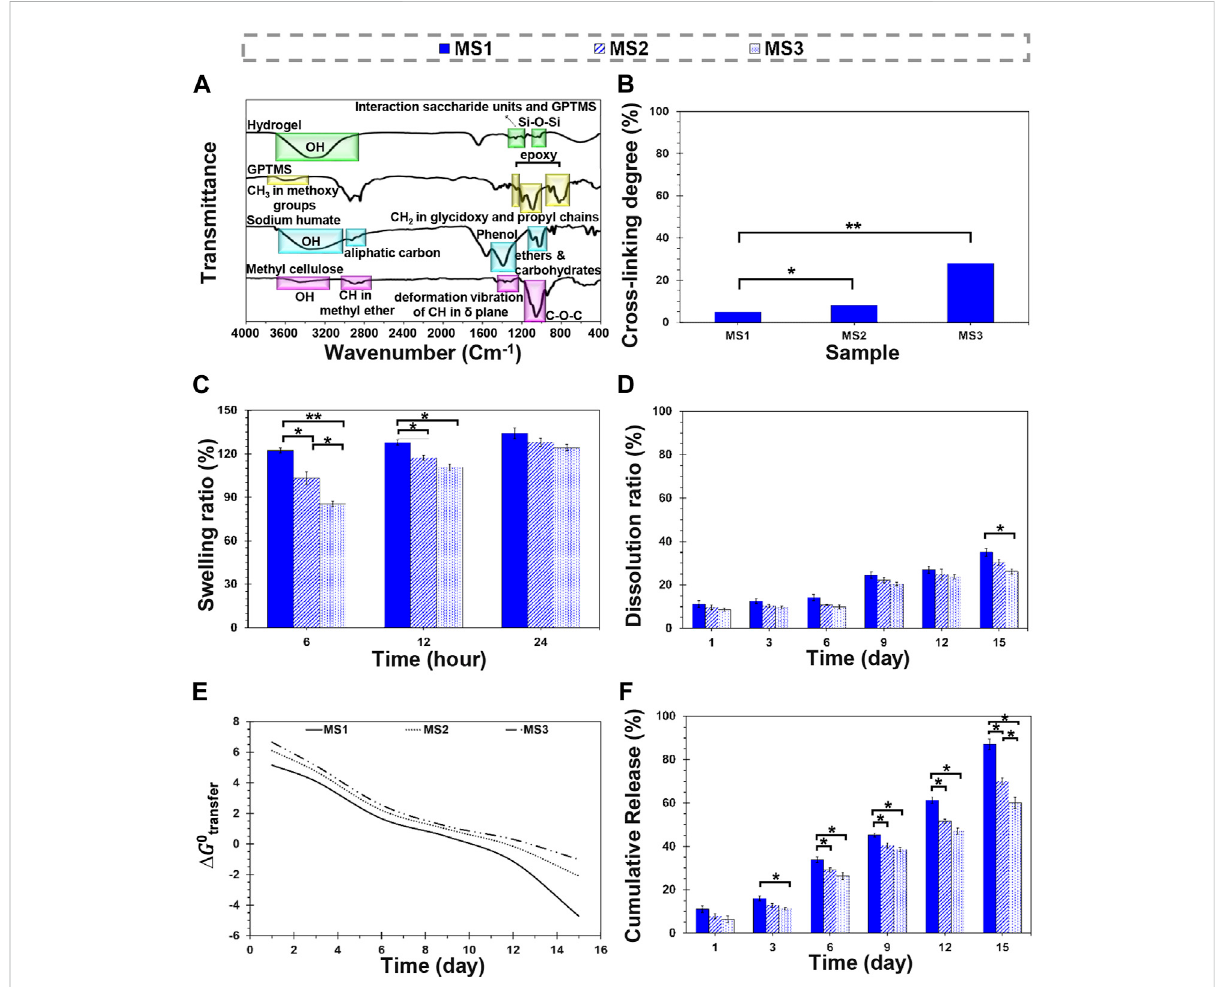
FIGURE 2 Physicochemical characterization of light-assisted thermo-responsive methylcellulose-sodium humate hydrogels. (A) FTIR spectra of raw materials and methylcellulose-based hydrogels, (B) cross-linking density of the composite hydrogels, (C) a 24-h swelling ratio, (D) a 15-day dissolution ratio ofMS1, MS2, and MS3hydrogels. (E) The plot ofGibbsfreeenergy changes of cisplatin transferand (F) therelease pro fi leof cisplatin from MS1, MS2, and MS3 hydrogels at 37 ° C ± 0.5 ° C. (Difference is considered to be statistically ( p ≤ 0.05*) and very statistically ( p ≤ 0.005**) signi fi